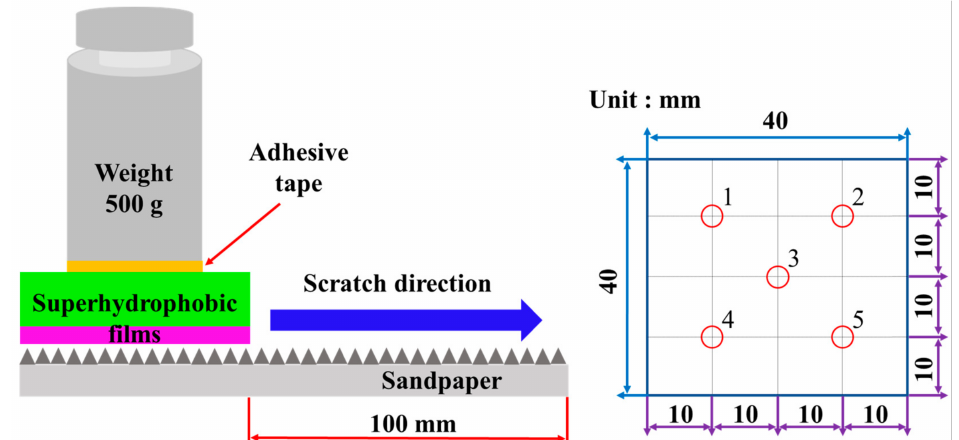
Figure 9. Schematic diagram of the scratch test with sandpaper for the fabricated superhydrophobic coated films and the five wettability measurement positions.